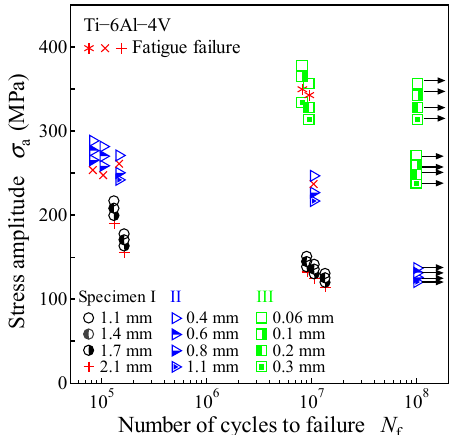
Figure 4. Experimental data sets used to draw Kitagawa–Takahashi diagram.